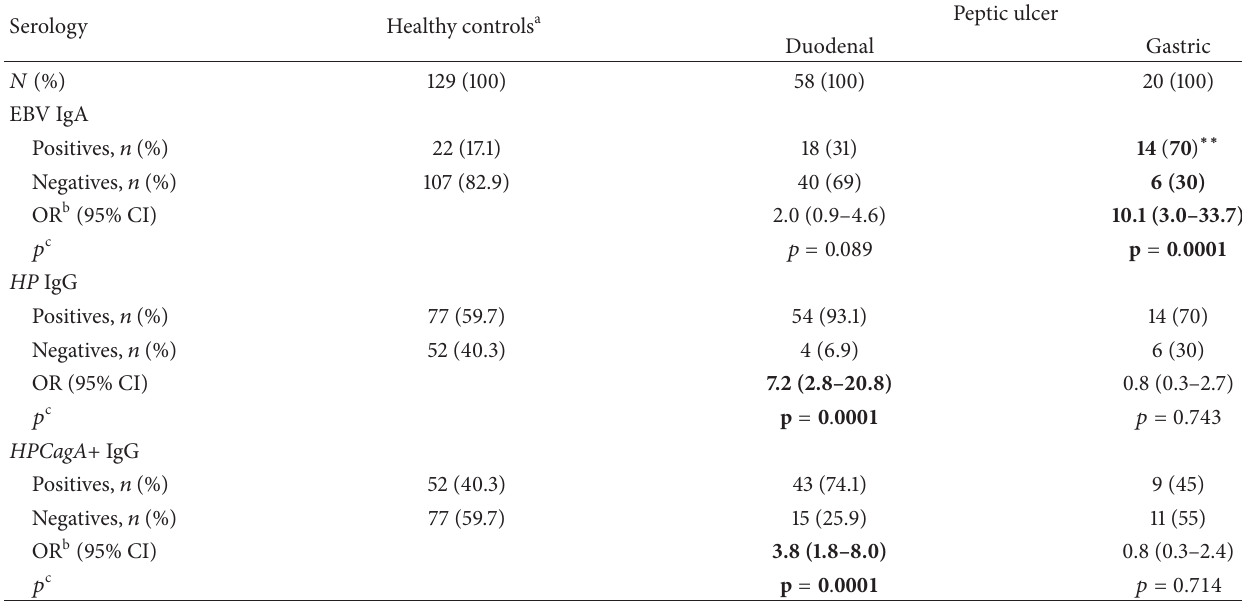
Table 3: Odds ratios for EBV or H. pylori infection and peptic ulcer